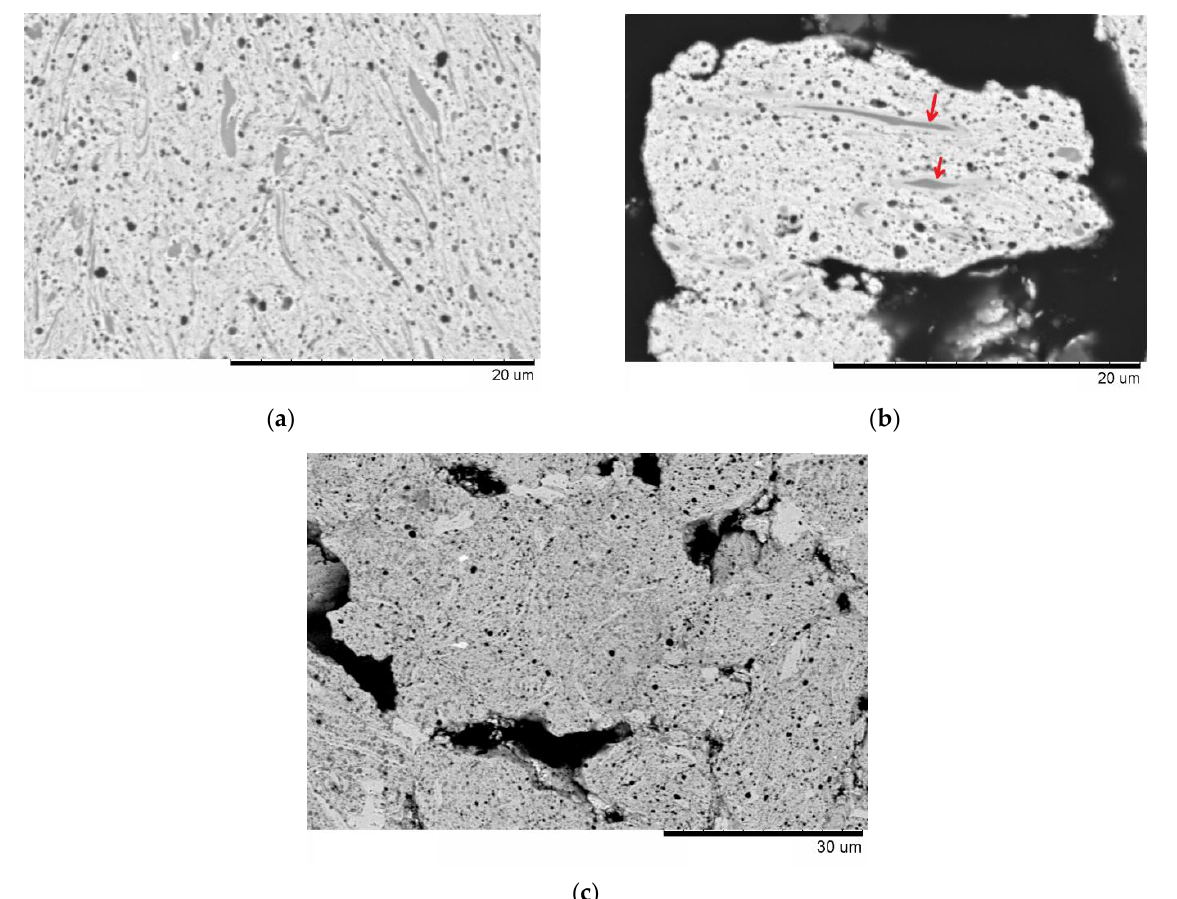
Figure 2. X-ray diffraction (XRD) pattern of the mechanically milled Ti–C–3Al powder mixtures, milling time 1 min ( a ), XRD pattern ( b ) and fracture surface ( c ) of the material obtained by consolidation of the mechanically milled mixture by SPS at 550 °C for 3 min followed by annealing at 800 °C for 10 min.